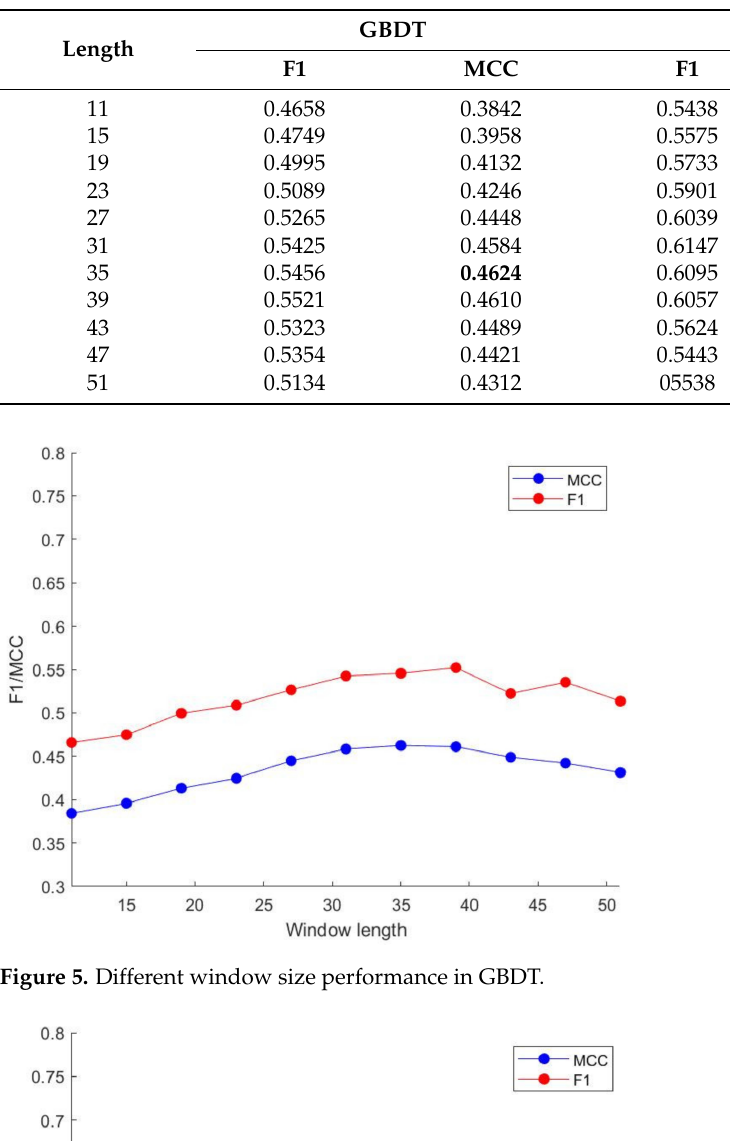
Table 5. Performance comparison of different window sizes.